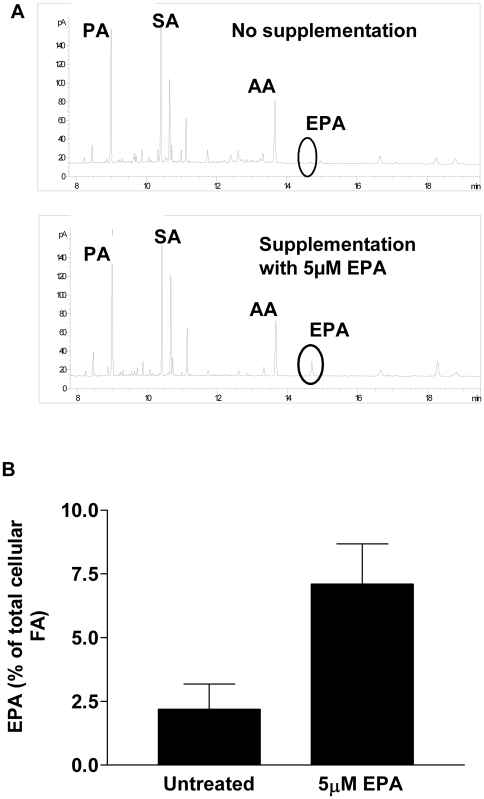
The effects of EPA supplementation on the fatty acid content of endothelial cell phospholoipds.(A and B) The concentration of EPA in membrane phospholipids was increased after supplementation of culture medium with EPA for 24 h. Error bars indicate SEM. AA, arachidonic acid; FA, fatty acid; PA, palmitic acid; SA, stearic acid.